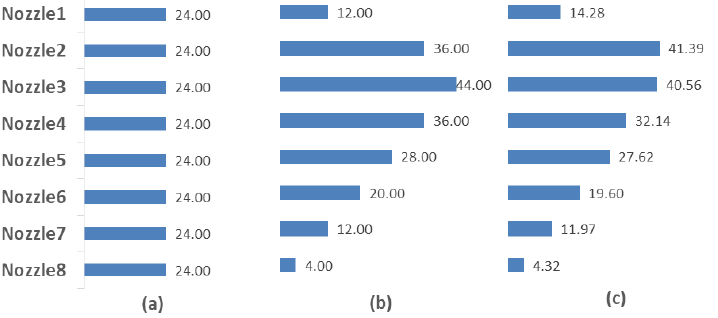
Figure 13. AIG nozzle flow-rate for the upper-skewed profile (unit, m/s). ( a ) Constant injection; ( b ) adjusted injection; ( c ) optimized injection. Table 3. RMS of NH 3 /NO molar ratio at the inlet of the catalyst layer for the upper-skewed profile. Constant